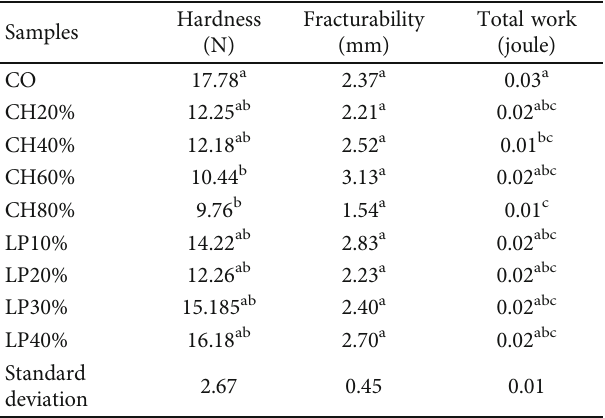
Table 2: Changes in texture parameters of crackers in response to replacement of wheat by chickpea and lupine fl